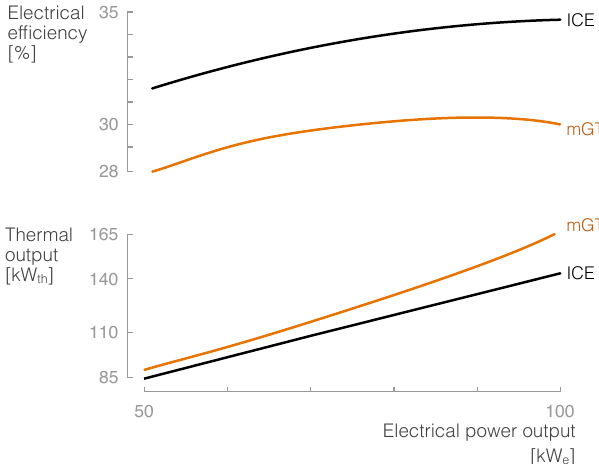
Figure 2. The reciprocating ICE offers a higher electrical efficiency compared to the mGT cycle, also at part load operation. However, both cycles present a very similar thermal efficiency ( ∼ 50%). Data sources: